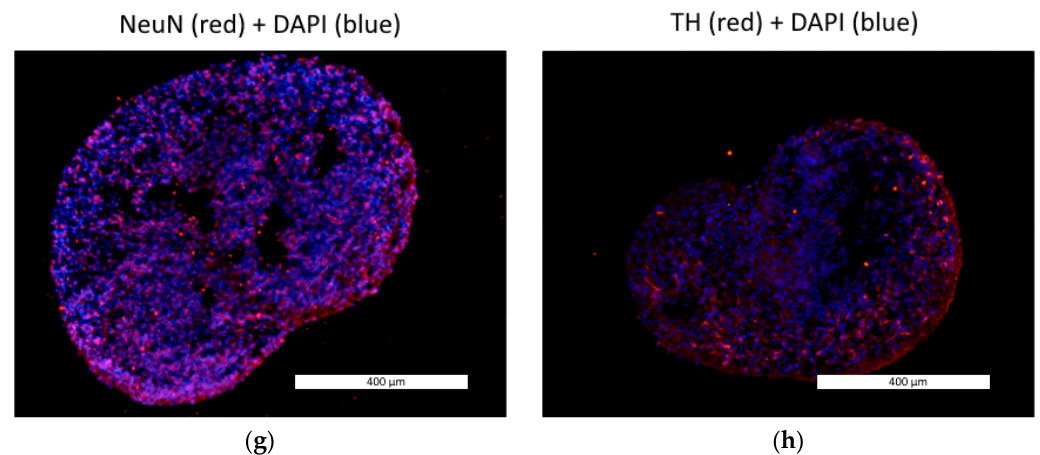
Figure 3. The 3D neural spheroids expressed neural cell markers: ( a ) TUBB3 (green); ( b ) GFAP (red); ( c ) TUBB3 (green) and GFAP (red); ( d ) Nestin (green); ( e ) hNCAM (red); ( f ) Nestin (green) and hNCAM (red); ( g ) NeuN (red); ( h ) TH (red); DAPY-stained cell nuclei in all pictures are blue. Fluorescence microscopy, the scale length in all pictures is 400 µm.